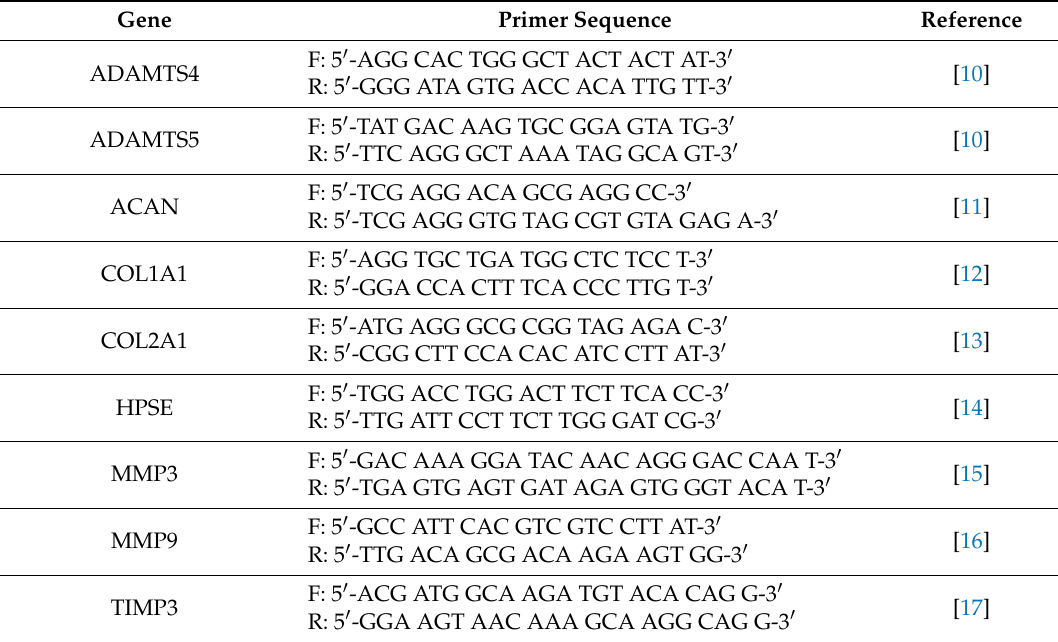
Table 1. Primer sequences used in gene expression